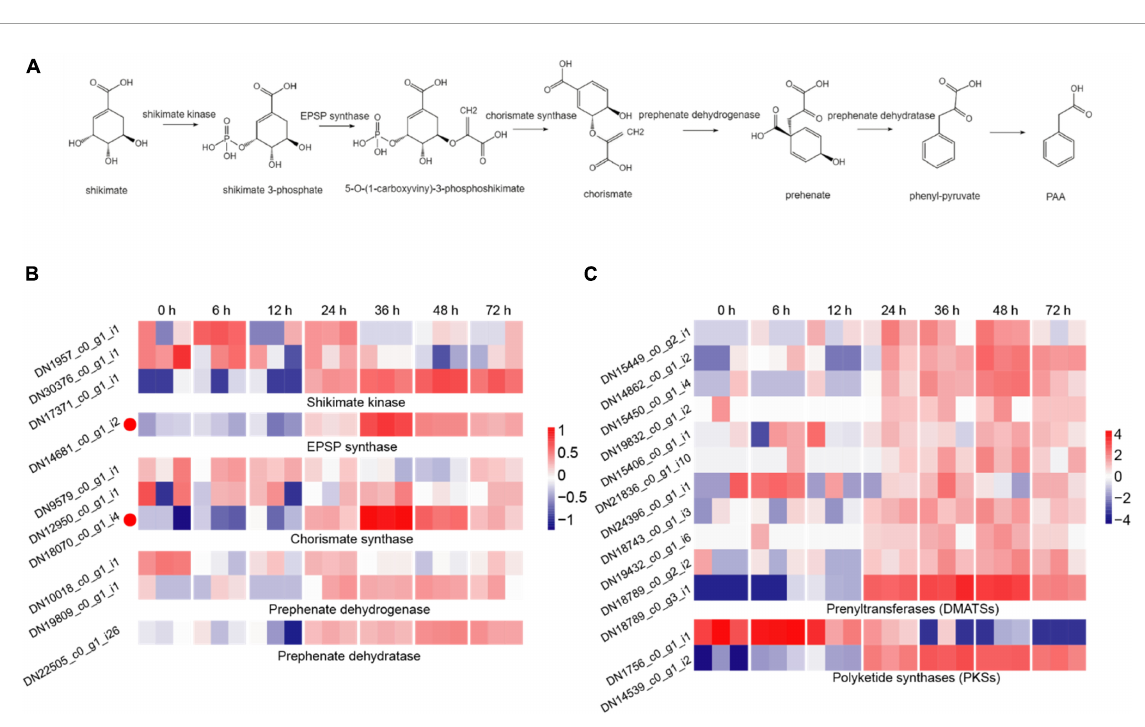
The transcriptomic results showed that the gene expression levels of 12, 13, 51, 55, 69, and 53 CAZyme families were gradually up-regulated from the 6 to 72 hpi ( Figure 4A ).